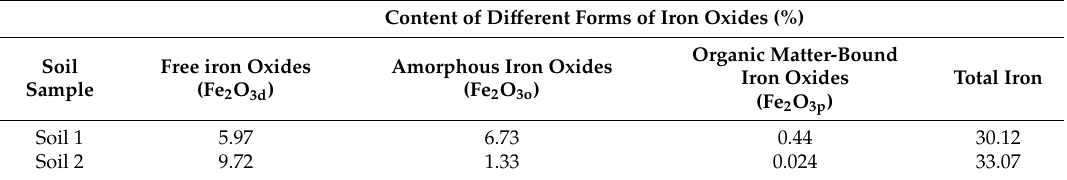
Table 2. Content of different forms of iron oxides in two sandy loam soils used.